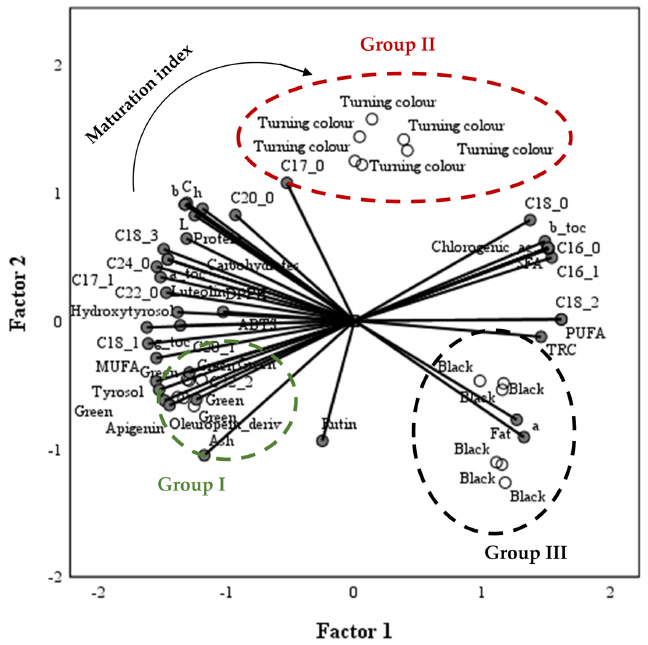
Figure 3. Principal components analysis obtained from the physic-chemical and antioxidant properties of “ table olive flours ” obtained from naturally fermented olives at different maturation ties of “table olive flours” obtained from naturally fermented olives at different maturation indexes. indexes. The PCA factors explained 87.4% of the total variance. The PCA factors explained 87.4% of the total